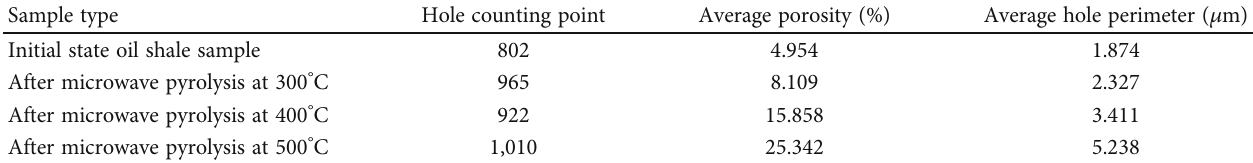
Figure 13: Changes in pores and cracks of oil shale under conductive heating. (a) Curve of changes in the perimeter of a single pore of oil shale. (b) Curve of changes in a single pore of oil shale. Table 3: Data on holes before and after microwave